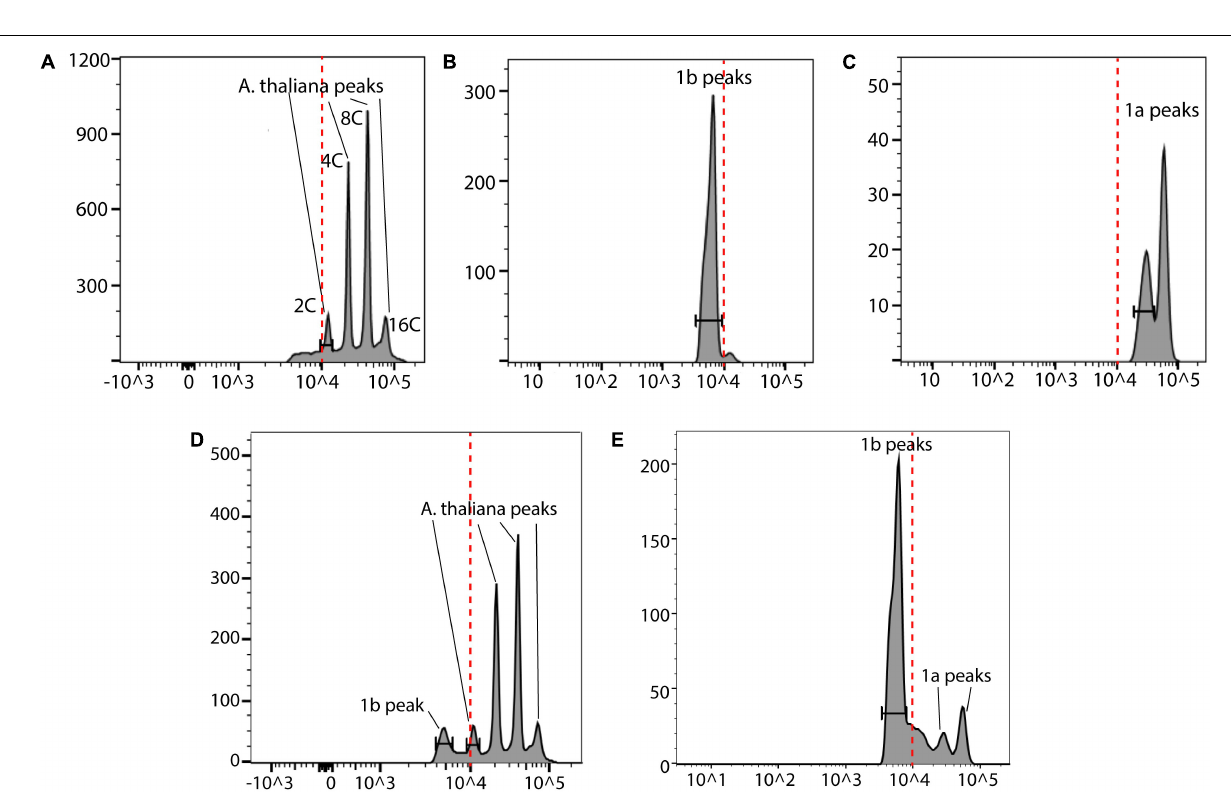
Frontiers in Plant Science |